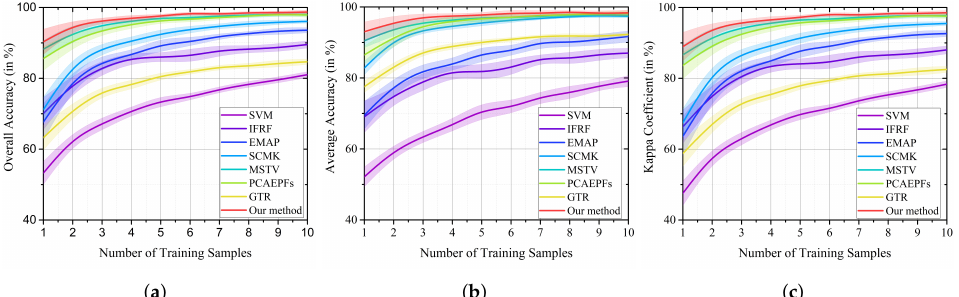
Figure 6. Classification performance of different approaches on the Indian Pines with different numbers of training samples. ( a ) OA. ( b ) AA. ( c ) Kappa. The widths of the line areas are the standard deviation of accuracies produced in ten experiments. Table 2. Classification accuracies of all methods on Indian Pines dataset. The bold denotes the best classification accuracy.